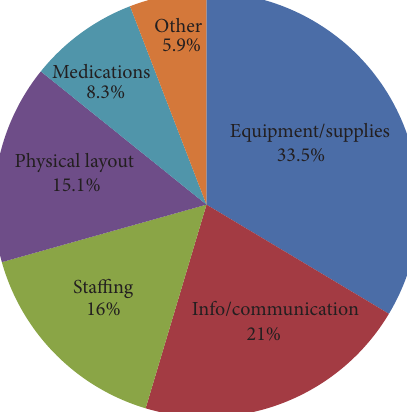
Figure 2: Distribution of operational failures by category ( 𝑛 = 2 , 391 ).